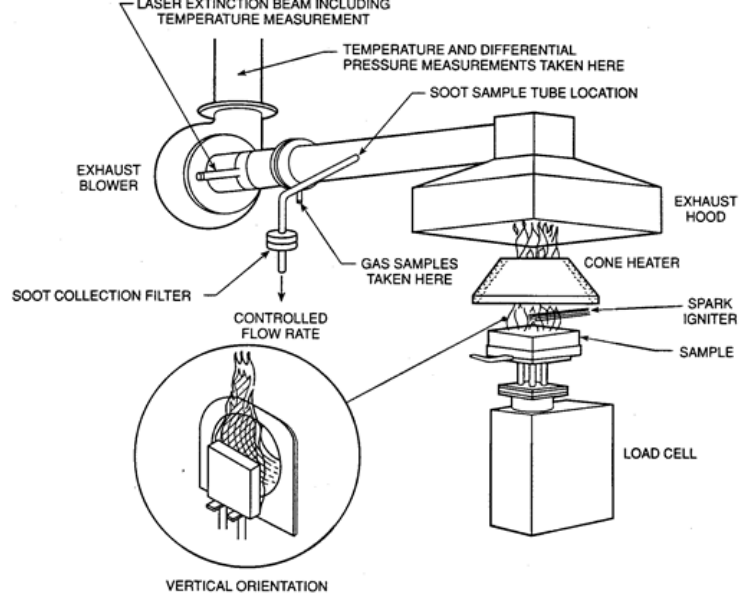
Figure 6. Small-scale cone calorimeter used in this study (Hurley). 328